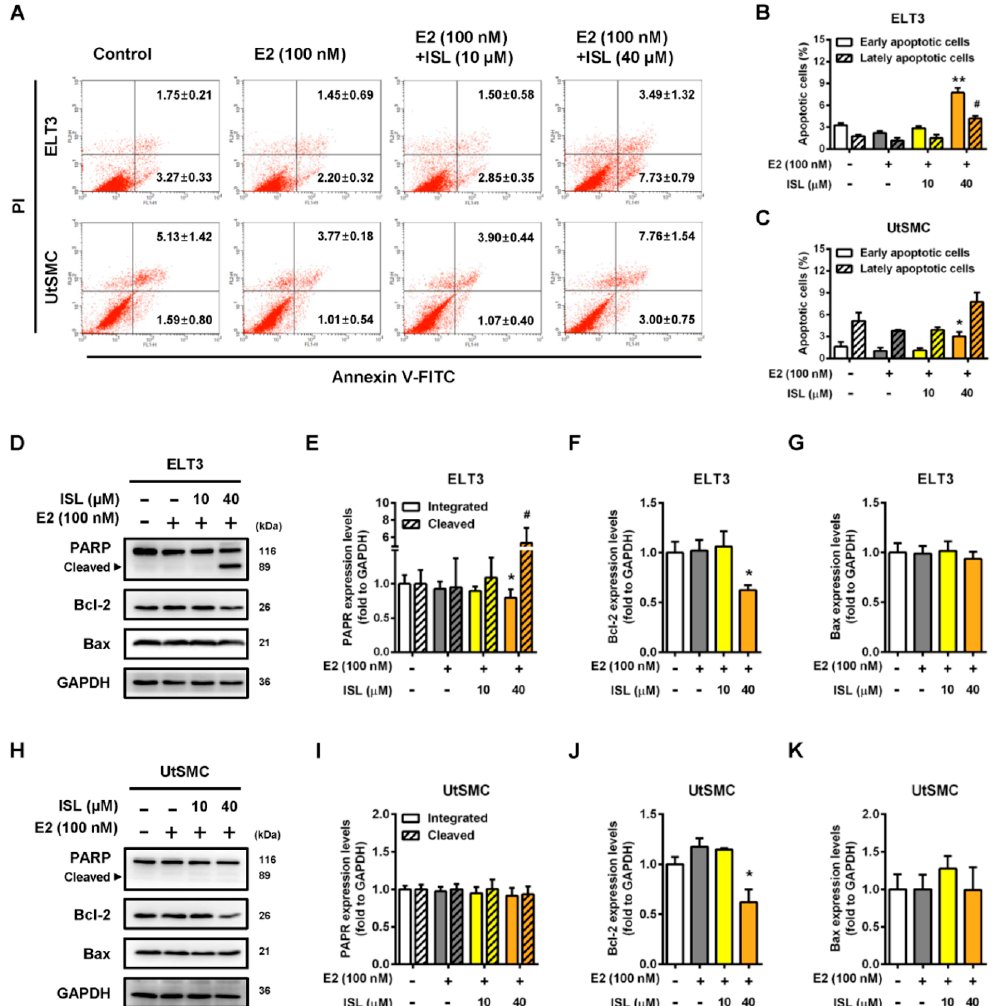
Figure 5. ISL induced cell apoptosis via upregulation of apoptotic associated protein expression in ELT3 cells. ( A ) ETL3 and UtSMC cells were treated with E2 (100 nM) alone or a combination of E2 and ISL (10 or 40 µ M) for 48 h. Cells were stained with propidium iodide and Annexin V-FITC, and the apoptosis rates were analyzed by the flow cytometry. ( B , C ) The quantitative data of apoptotic cell death in early and late phases are shown. After treatment as indicated above, the apoptotic-associated proteins were analyzed using Western blot in ( D ) ELT3 and ( H ) UtSMC cells. Each target protein was